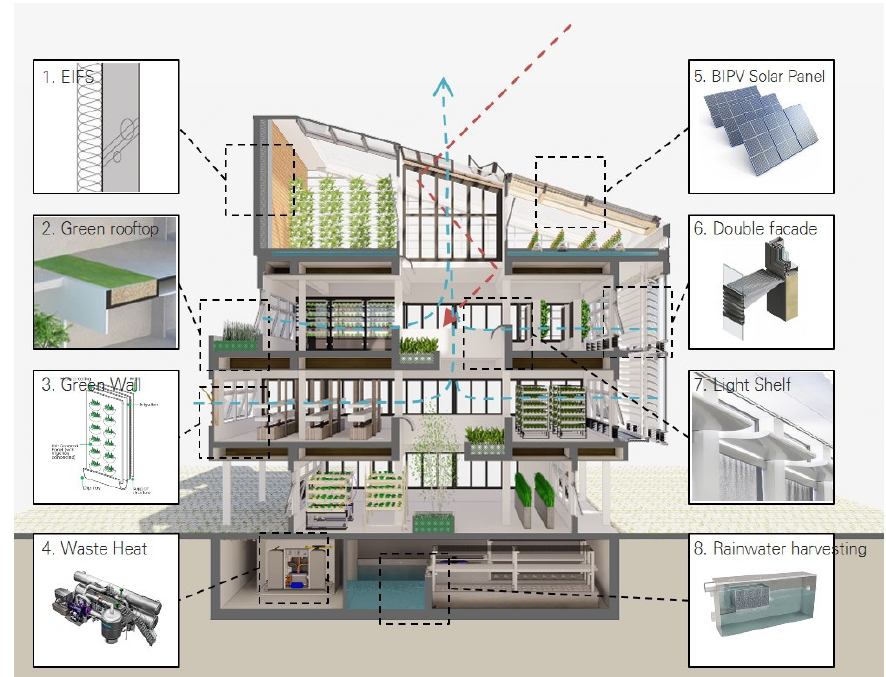
Figure 4. Smart farm application plan for buildings.